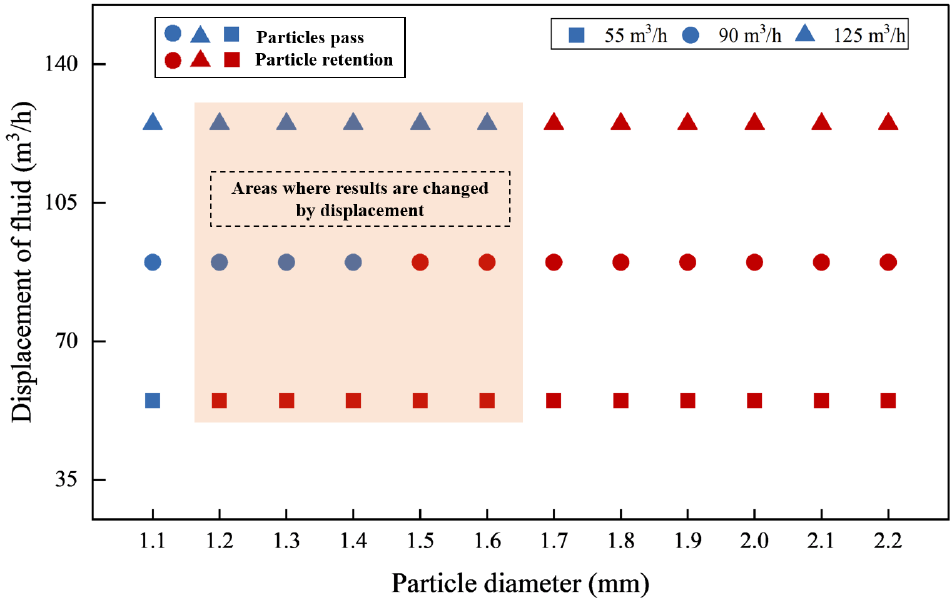
Figure 18. Flow properties of LCMs under the action of the low, medium, and high displacement fluids.